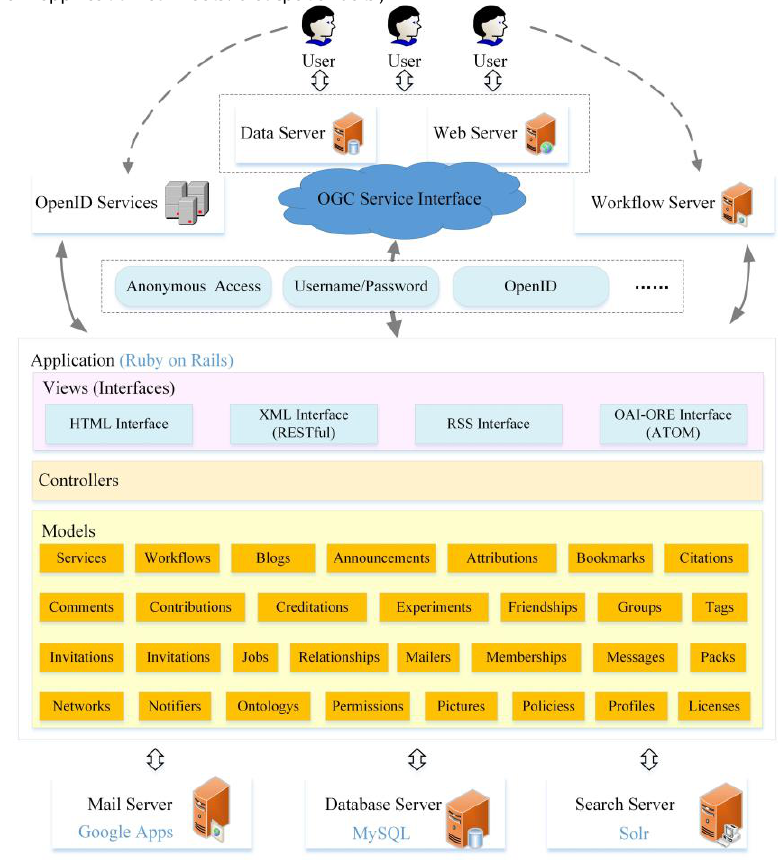
Figure 1. The architecture of the